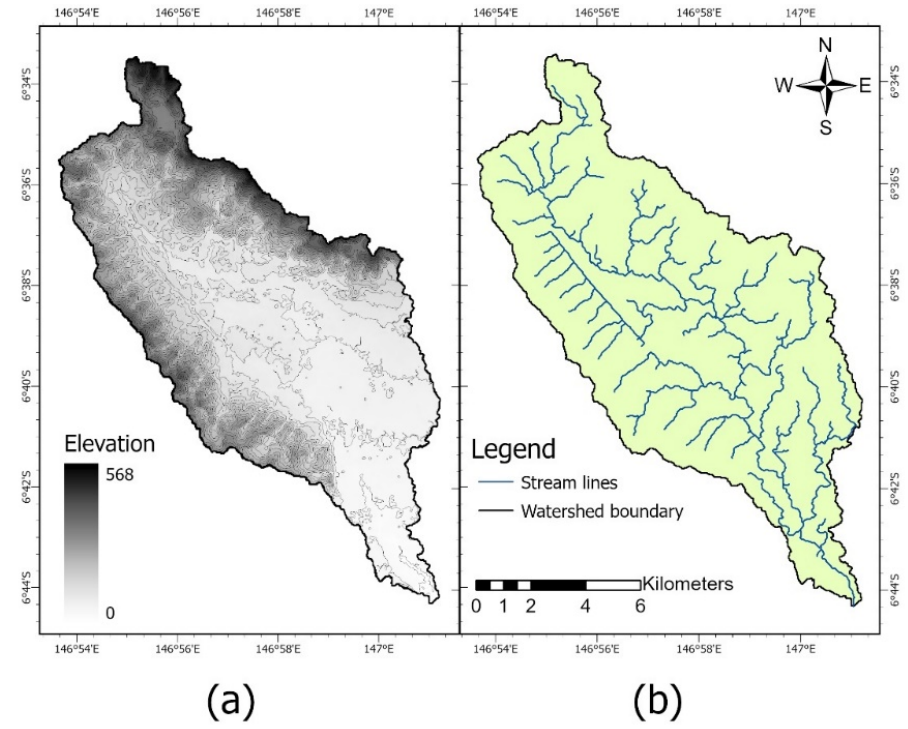
Figure 4. Bumbu Watershed Polygon overlain with ( a ) 20 m elevation contour lines and ( b ) major stream lines.